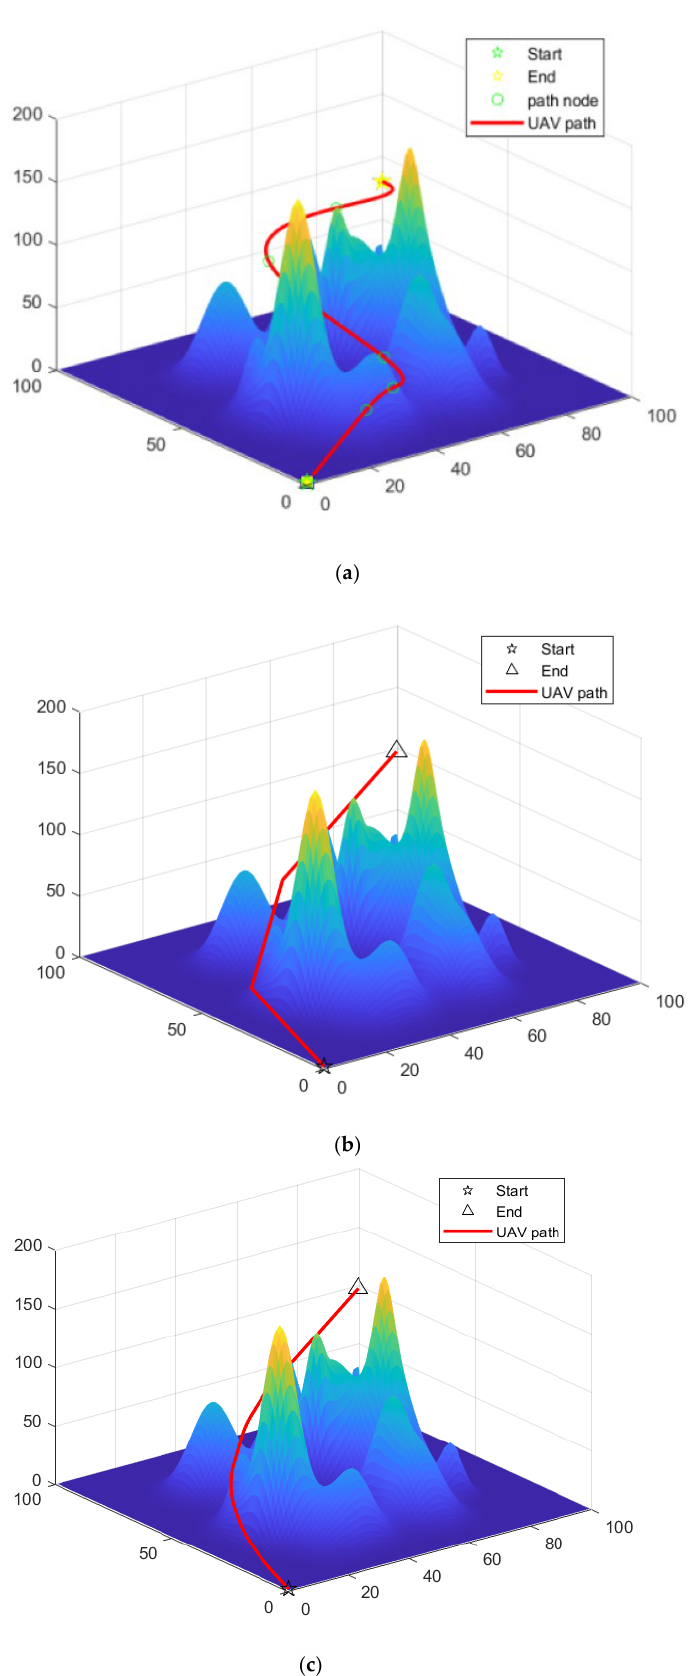
Figure 11. Results of several algorithms in the same environment: ( a ) IGA, ( b ) PRM, ( c ) IPRM. Table 2. The experimental results using different algorithms.